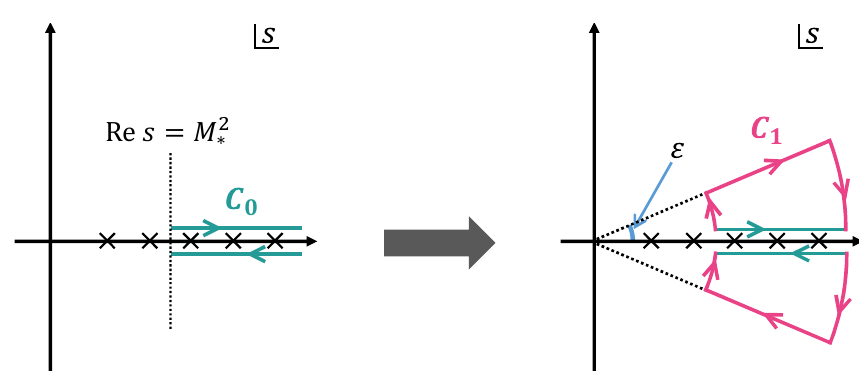
Figure 2 . The deformation of the integration contours, parameterized by an angle ε > 0 . Simple poles associated with the Regge states are denoted by ×